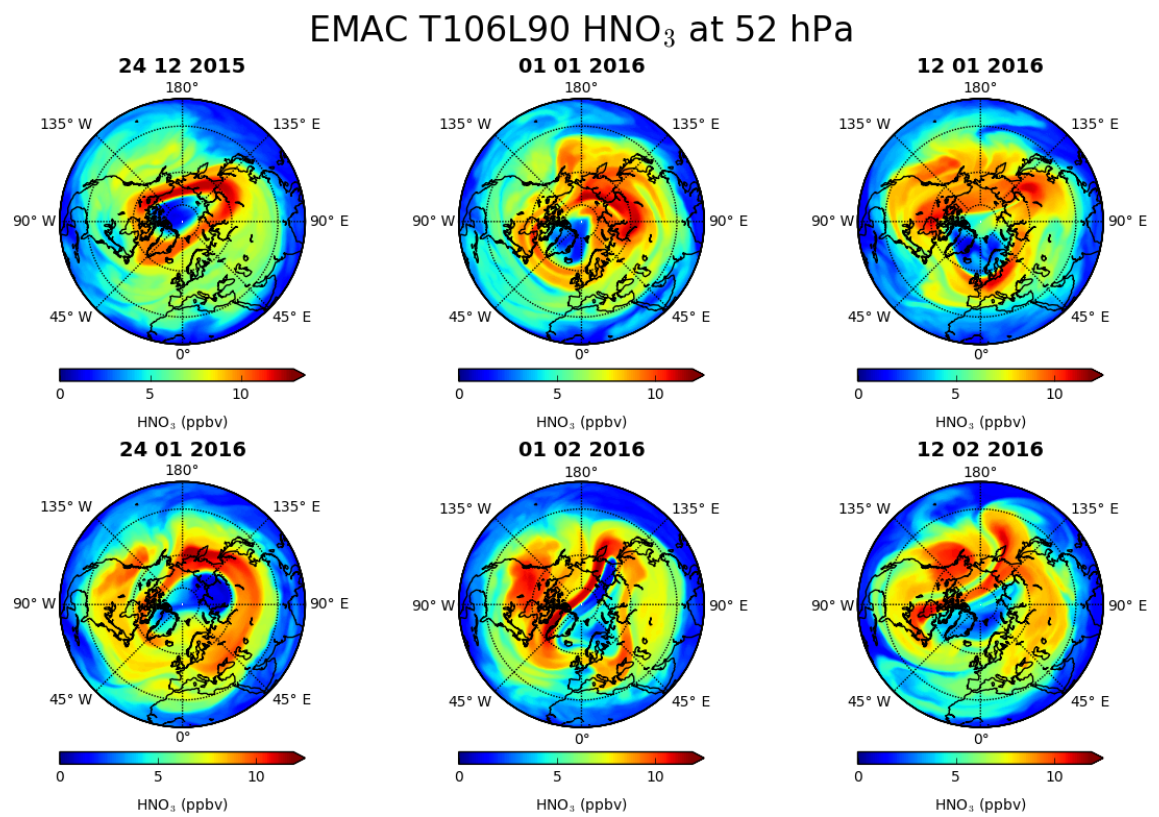
Figure 3. Distribution of HNO 3 as simulated with EMAC T106L90 at 52hPa on certain dates between 24 December 2015 and 12 Febru- ary 2016.